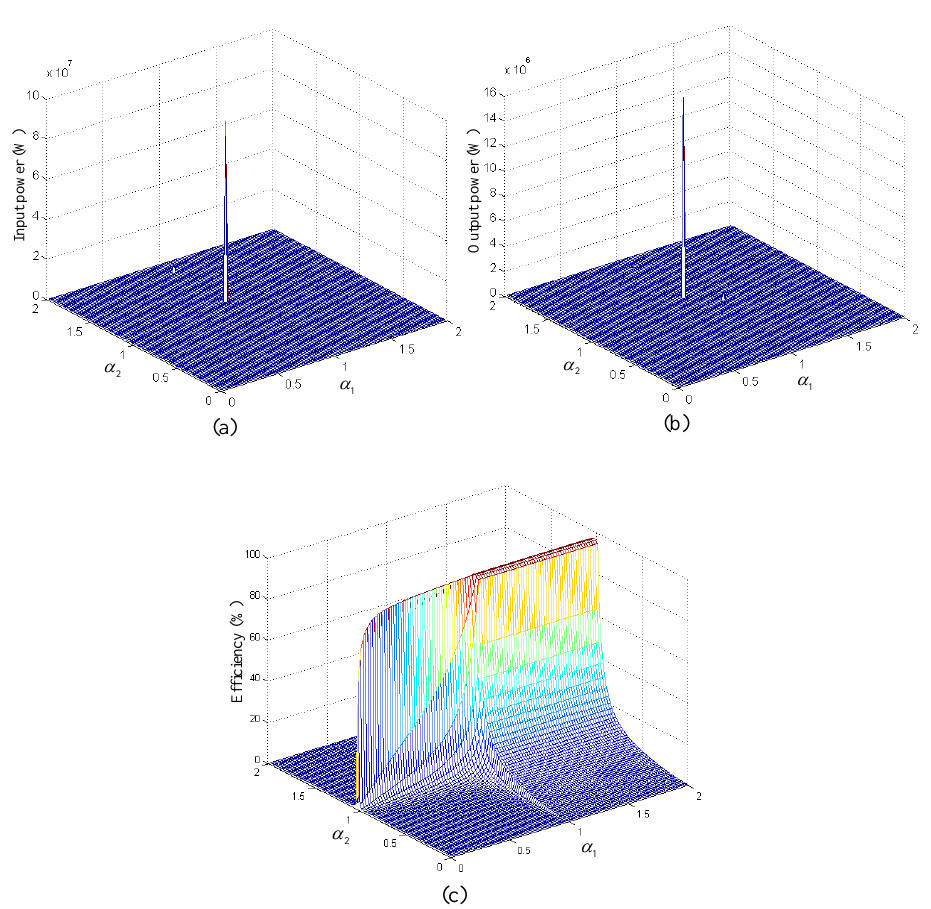
Figure 4. Three-dimensional (3-D) demonstration of input power, output power, and transmission efficiency versus fractional order ( α 1 , α 2 ) when β = 1: ( a ) Input power versus α 1 and α 2 when β = 1; ( b ) Output power versus α 1 and α 2 when β = 1; ( c ) Transmission efficiency versus α 1 and α 2 when β = 1. From Figures 3 and 4, it can be seen that the variation of transmission efficiency with α 1 is completely different from that with α 2 , but the variation of output power with α 1 is very similar to that with α 2 . When the system is in resonance, the fractional order of the inductances is β = 1, and when the fractional order of the receiver’s resonant capacitor α 2 is a fixed value, the transmission efficiency increases with the increase of α 1 in the case of 0 < α 1 ≤ 1, and the transmission efficiency remains constant in the case of 1 < α 1 < 2. The output power has a maximum as α 1 increases in the range of 0 < α 1 < 2, the corresponding values of α 1 are different under different fixed values of α 2 , but they are all close to 1 when β = 1. However, when the fractional order of the transmitter’s resonant capacitor α 1 is a fixed value, the transmission efficiency increases first and then decreases with the increase of α 2 , which has a maximum value, and the corresponding value of α 2 is close to 1. The output